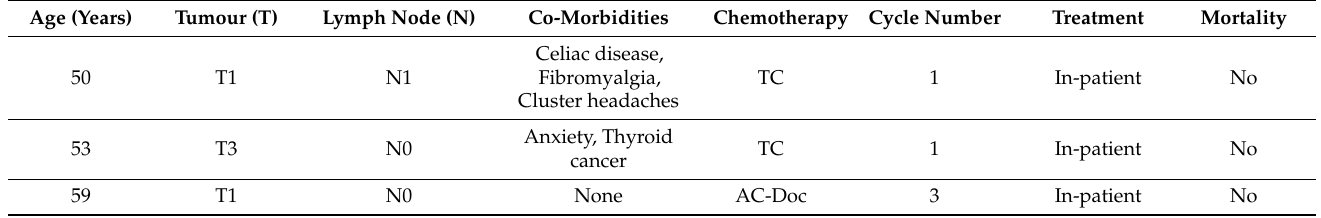
Table 4. Demographic, diagnostic, and treatment information for the three patients who developed febrile neutropenia while receiving